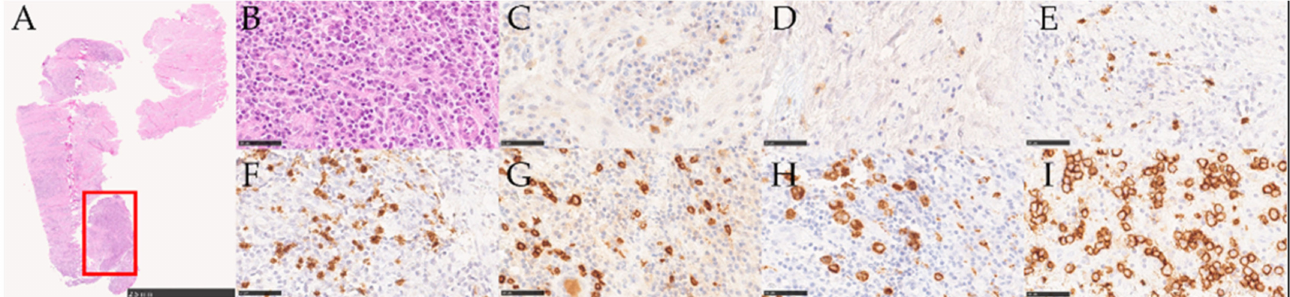
Figure 4. Stained samples of a PI lesion: ( A ) overview of a section stained with HE; ( B ) detailed view of ( A ); ( C ) CD3+; ( D ) CD4+; ( E ) CD8+; ( F ) CD15+; ( G ) CD20+; ( H ) CD68+; ( I ) CD138+.